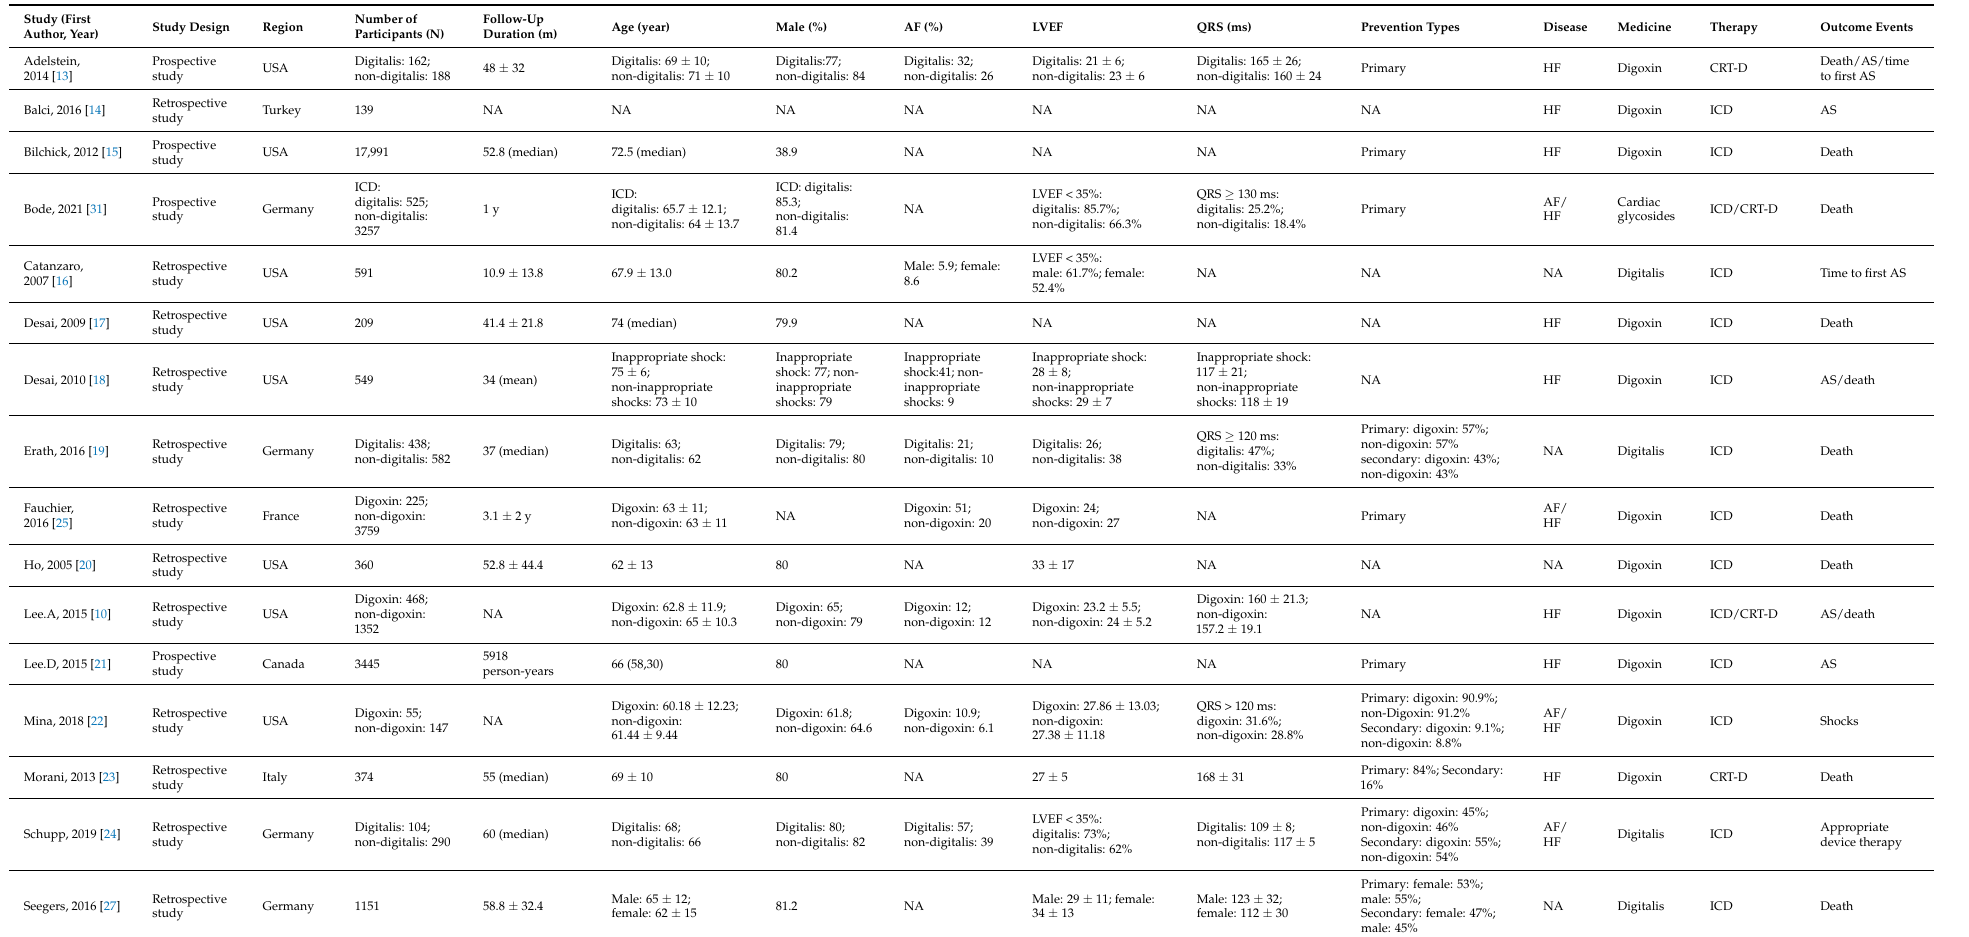
Table 1. Basic Characteristics of Studies Included in the